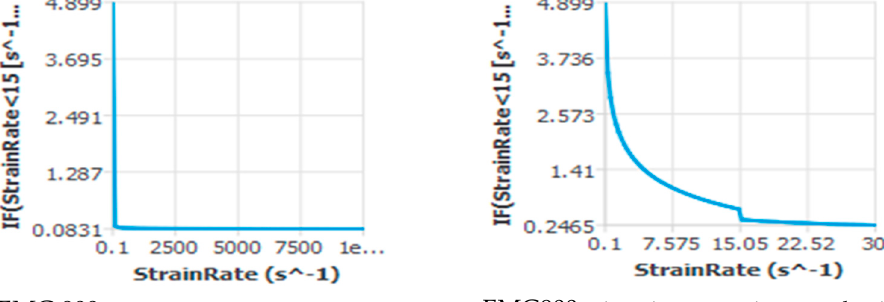
Figure 8. Dependence of viscosity on the strain rate and detail in ANSYS Fluent.